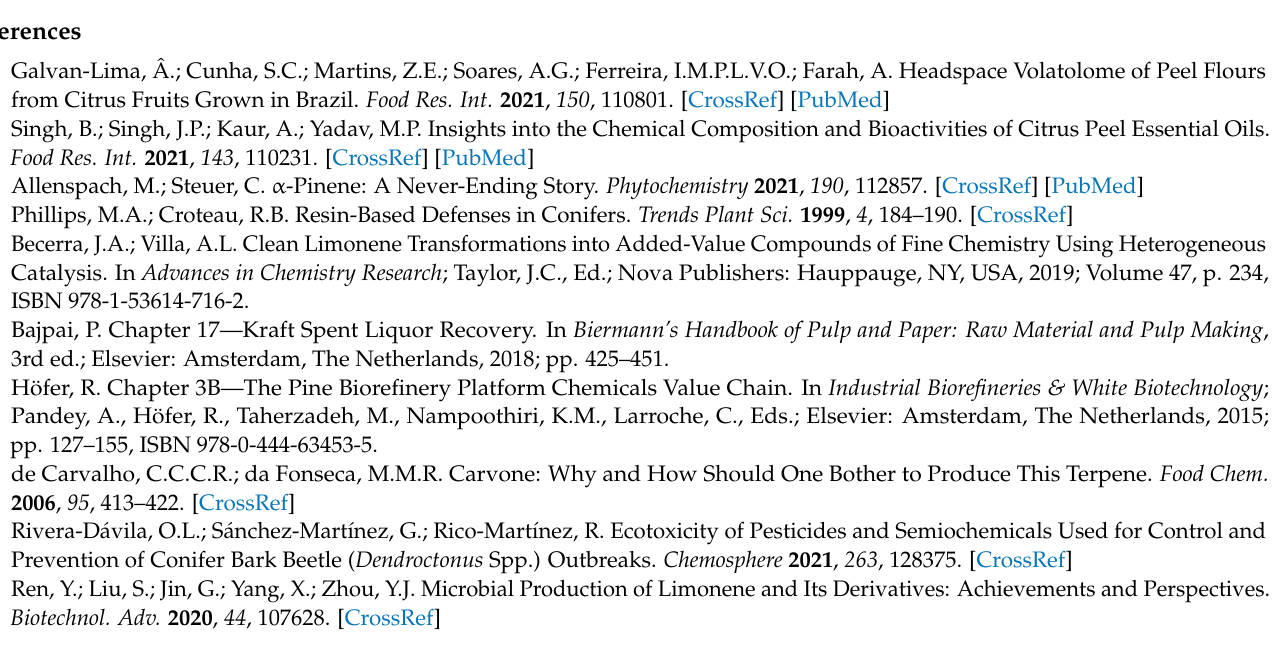
Table S4. Inventory data for the processes considered in the production of verbenone in the separation zone; Table S5. Inventory data for the processes considered in the production of carvone in